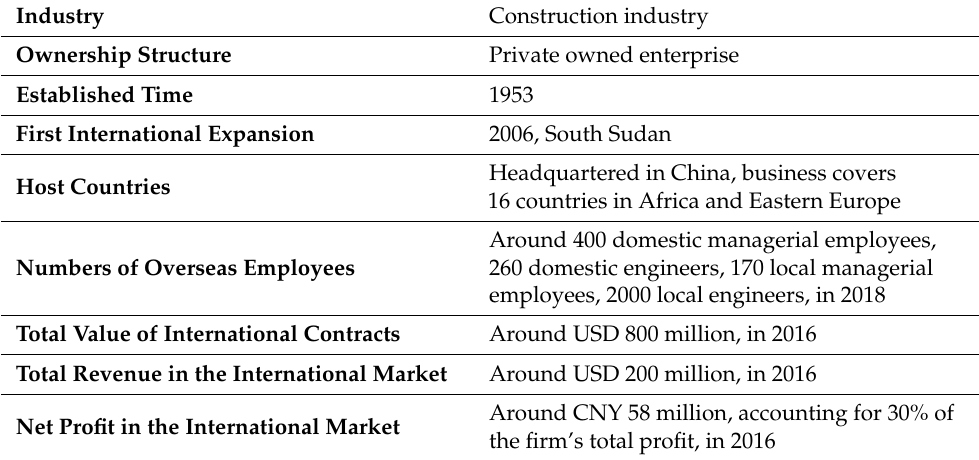
Table 1. Profile of the case